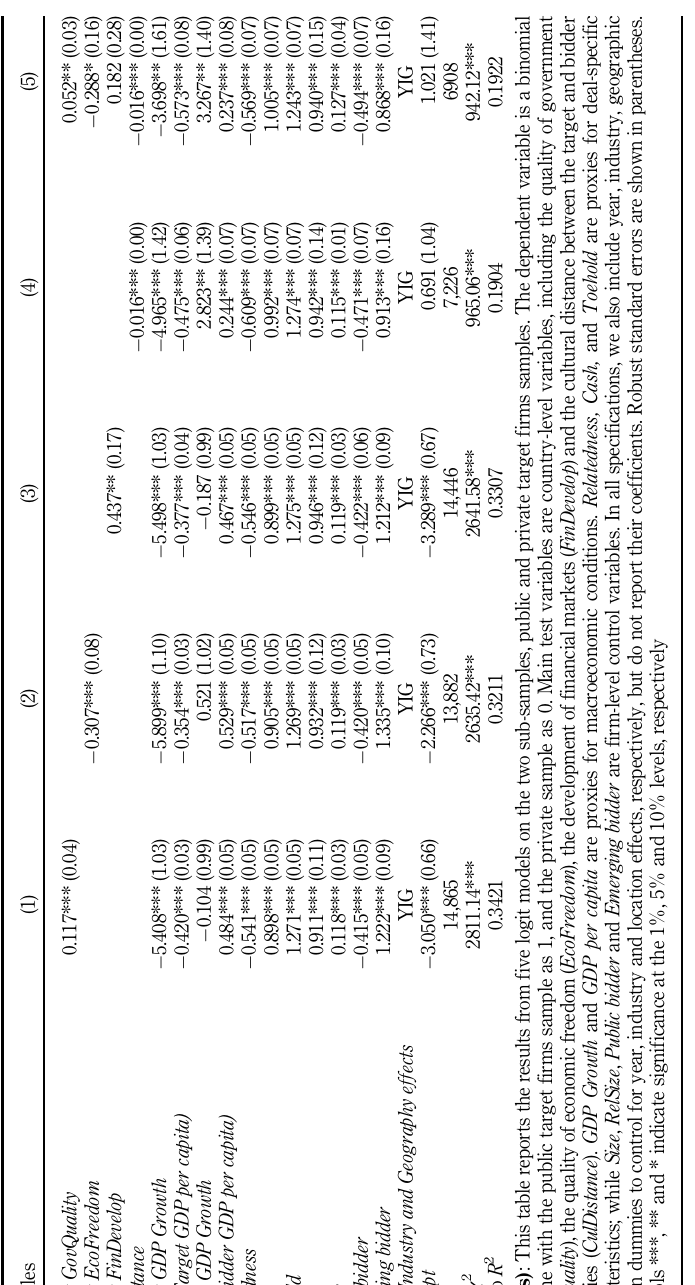
Table 4. Cross-country determinants of target status choices in cross- border